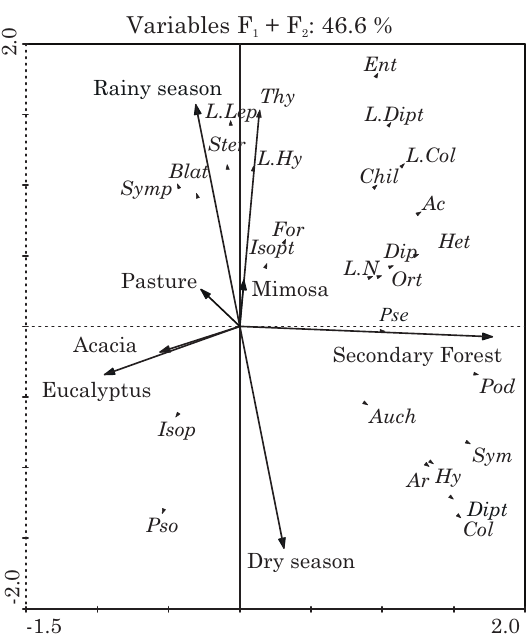
Figure 3. Principal Component Analysis (PCA) for the abundance of soil fauna groups in the stands studied in the dry and rainy seasons. Ac = Acari, Ar = Araneae, Auch = Auchenorryncha, Blat = Blattodea, Chil = Chilopoda, Col = Coleoptera, Dip = Diplopoda, Dipt = Diptera, Ent = Entomobryomorpha, For = Formicidae, Het = Heteroptera, Hy = Hymenoptera, Isop = Isopoda, Isopt = Isoptera, L.Col = L. Coleoptera, L.Dipt = L. Dipteran, L.Lep = L. Lepidoptera, L.N = L. Neuroptera, L.Hy = L. Hymenoptera, Ort = Orthoptera, Pod = Poduromorpha, Pse = Pseudoscorpionida, Pso = Psocoptera, Ster = Sternorryncha, Symp = Symphyla, Sym = Symphypleona, Thy =